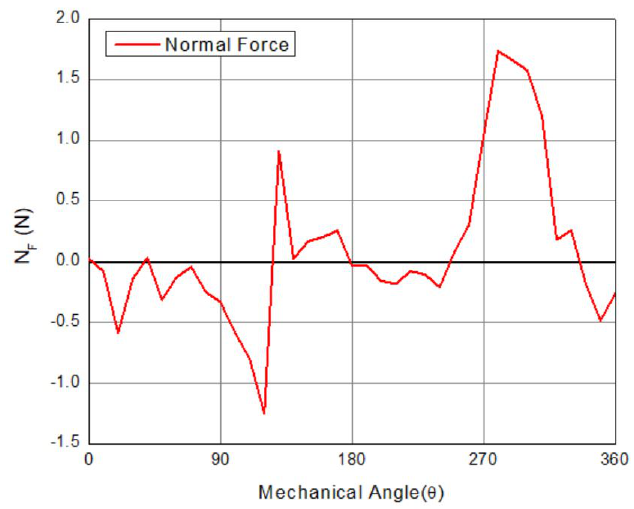
Figure 11. Normal force at different mechanical